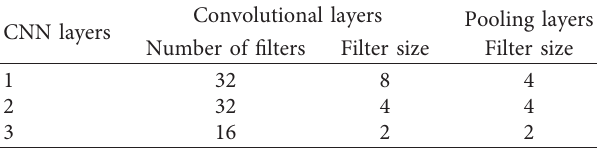
Table 1: The structures of the employed CNN